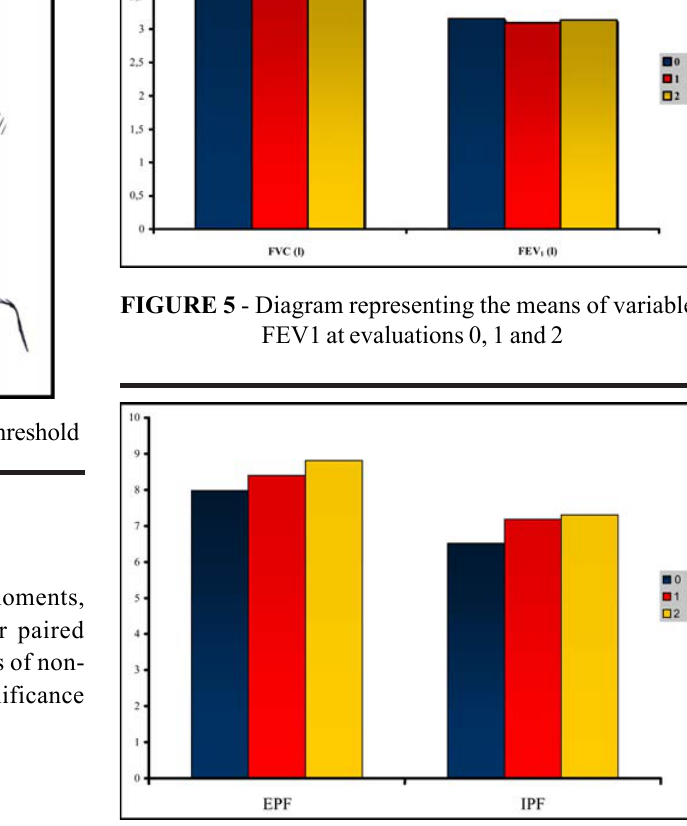
FIGURE 6 - Diagram representing the means of variables EPF and IPF at evaluations 0, 1 and